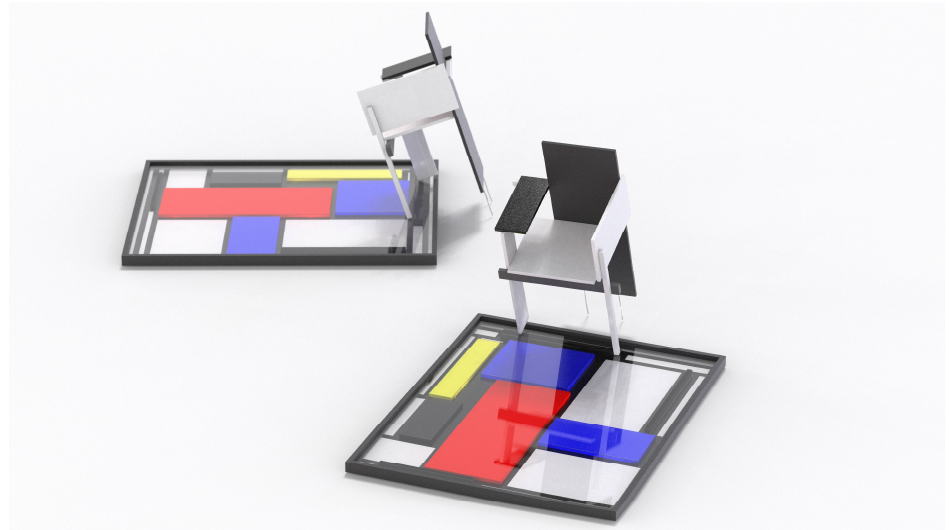
Figure 8. Vittoria Secondini, Daniele Rolli: Rietveld and dlevteiR.